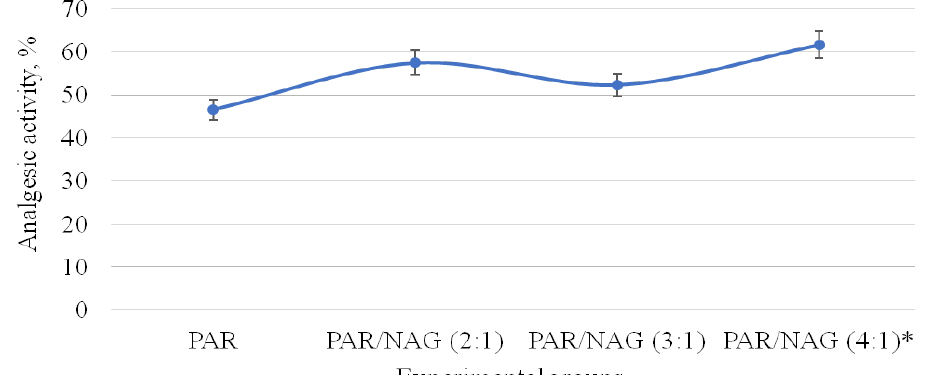
Fig. 1. The curve of changes in the analgesic activity of different ratios of paracetamol and N-acetyl-D-glucosamine in the composition : NAG – N-acetyl-D-glucosamine; PAR – paracetamol; * P <0.05 compared to group treated with